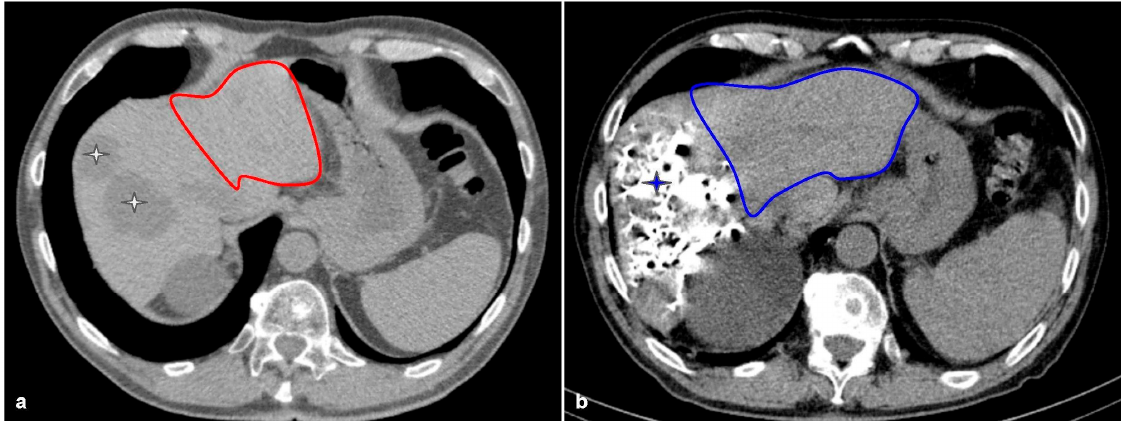
Figure 1. The case of a 70-year-old patient with synchronous bilobar CRLM. ( a ) CT volumetry of the FLR (red outline) is insufficient (FLR 20%, SPECT 20% and HIBA index of 8%); thus, a portal embolization with venous deprivation is performed. ( b ) The blue star marks the embolization material. The blue outline shows the exponential growth of the FLR after portal embolization (SPECT 58%, HIBA index 16%).